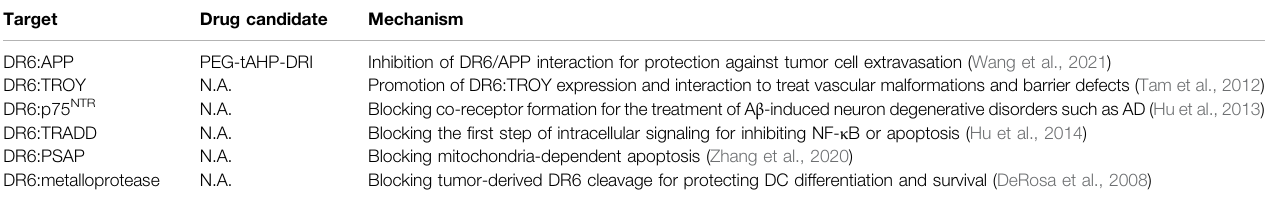
TABLE 1 | Potential drug targets for DR6-related